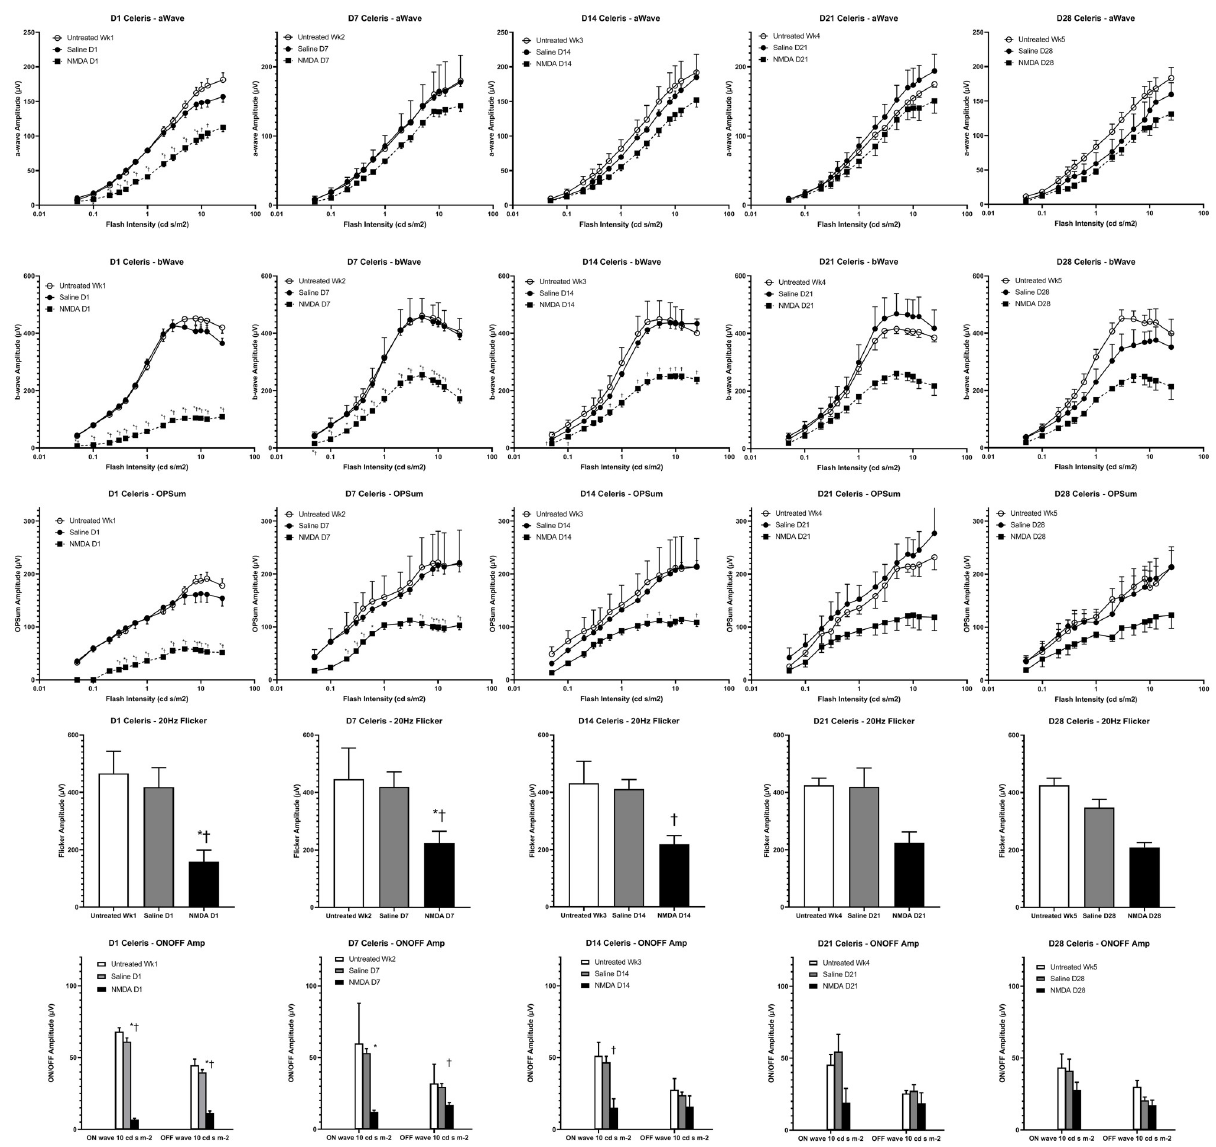
Fig 5. ERG results of NMDA-damaged, vehicle-treated, and age-matched undamaged controls. Undamaged chicks (n = 10 P7 to P21, n = 5 P28 to P35), NMDA-damaged chick eyes (OS), and saline vehicle-injected fellow chick eyes (OD) (n = 10, P7/D1 to P14/D7, n = 8, P21/D14, n = 6, P28/D21, n = 5, P35/D28) were examined with the Celeris ERG system. The data is organized by time (columns) and parameter (rows). From left to right, the columns represent one day post-injection (D1) and 7 days post-hatch (P7), D7/P14, D14/P21, D21/P28, and D28/P35. From top to bottom, the rows represent a-wave amplitudes, b-wave amplitudes, the amplitudes of the sum of oscillatory potentials (OPSum), flicker amplitudes at 20Hz, and ON/OFF bipolar cell response amplitudes. � indicates significance with vehicle (saline) controls, † indicates significance with undamaged controls.